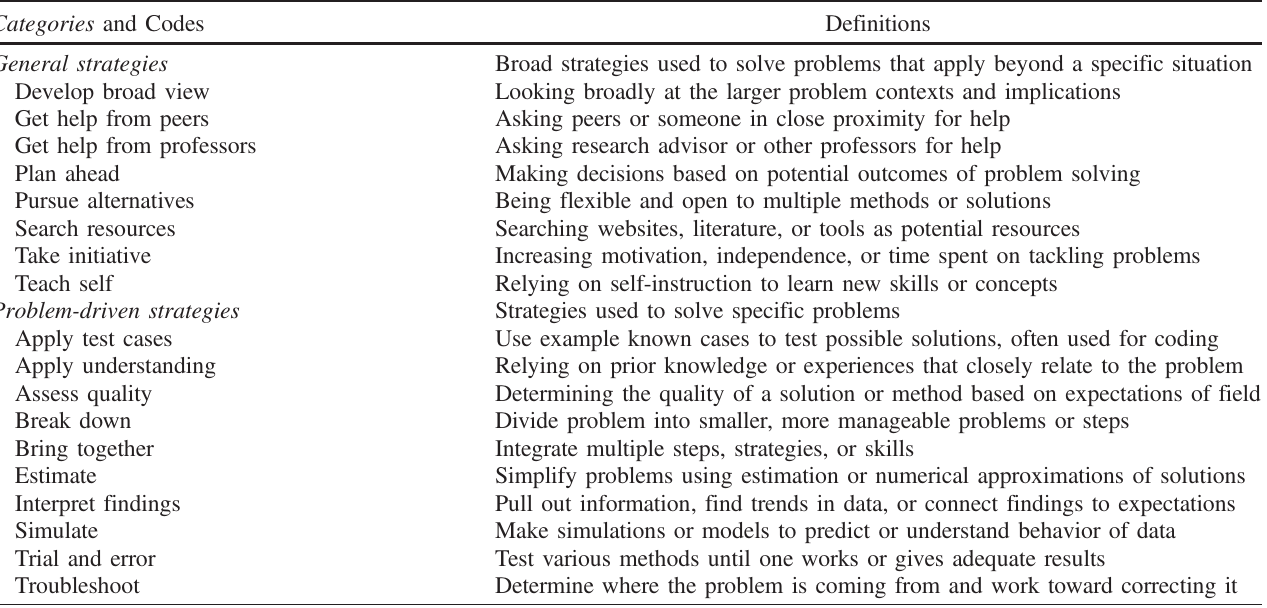
TABLE IV. Problem-solving strategy codebook. Italicized headings refer to grouped categories of several codes. Categories and